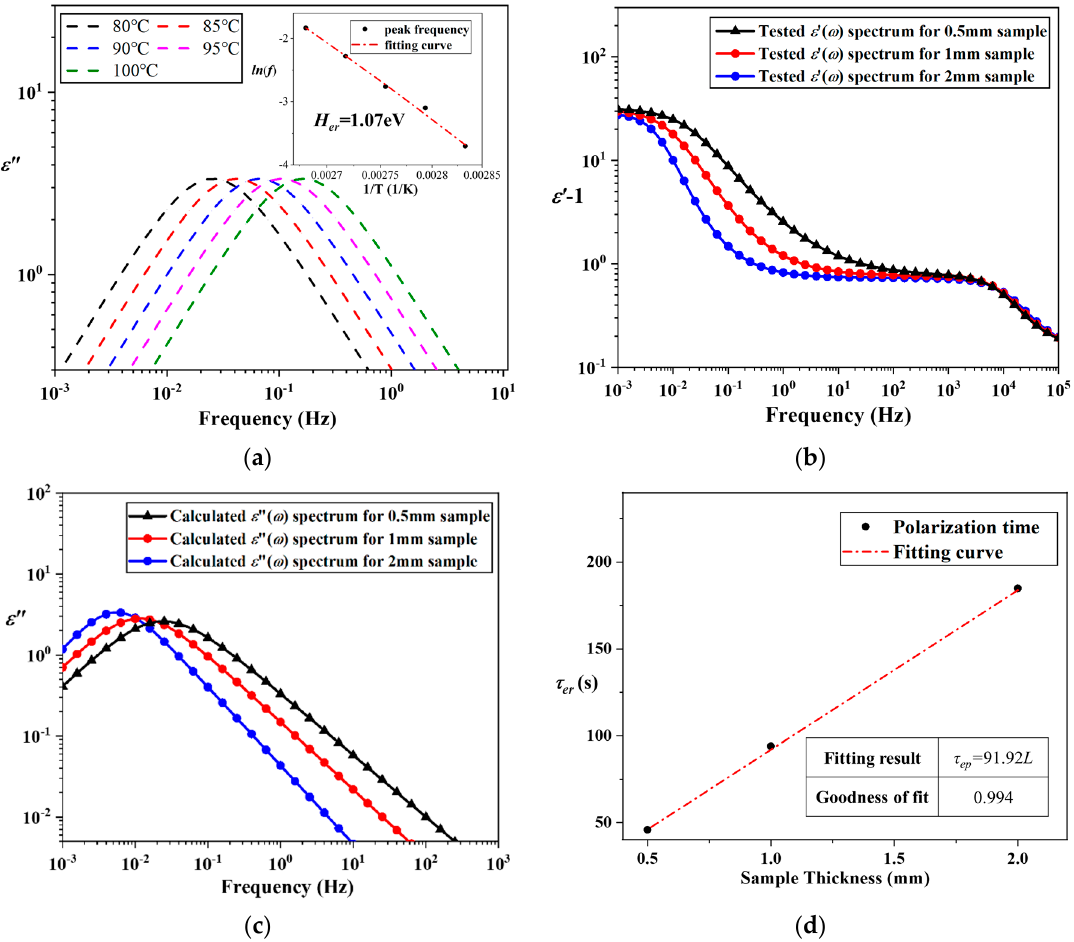
Figure 8. Related analysis data for electrode relaxation. ( a ) Extracted ε ” ( ω ) spectra of electrode relaxation at different temperatures, and fitting result of the electrode relaxation’s barrier height. ( b ) Measured ε ’ ( ω ) spectra of composite samples with different thicknesses. ( c ) Calculated electrode relaxation independent ε ” ( ω ) spectra for samples with different thicknesses. ( d ) Relationship between sample thickness and electrode relaxation’s polarization time.